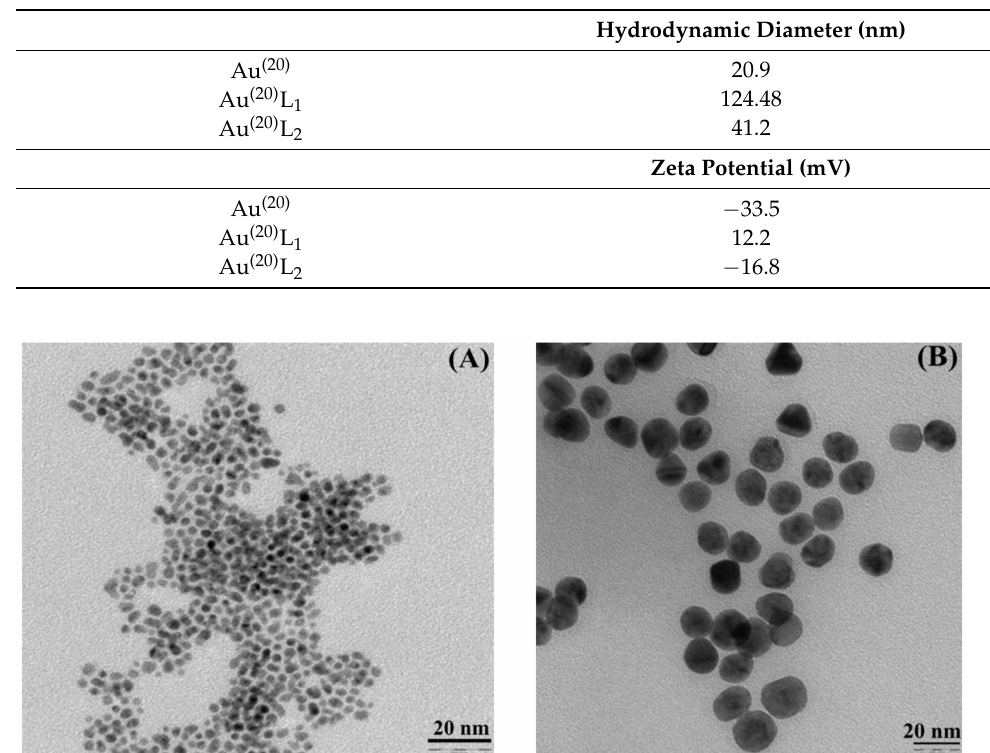
Table 1. Hydrodynamic diameters and zeta potentials of 20 nm naked AuNPs and ligand- bearing AuNPs.